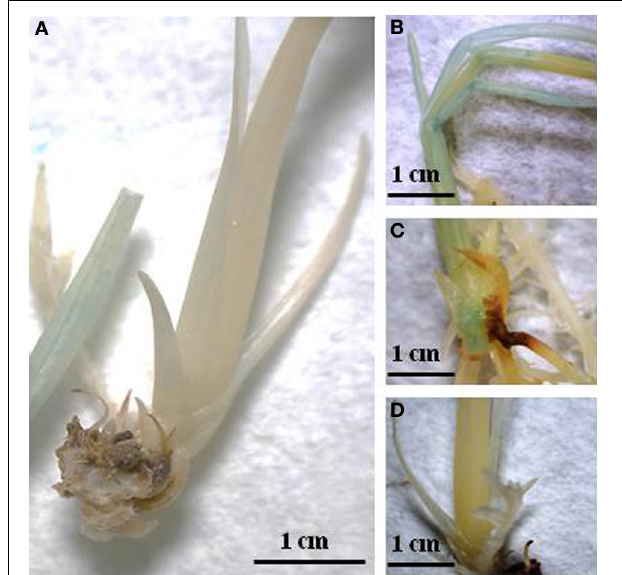
FIGURE 3 | Histochemical GUS staining; (A) Wild type; (B) Transgenic rice exhibiting high GUS expression; (C) Transgenic rice exhibiting medium GUS expression; (D) Transgenic rice exhibiting low GUS